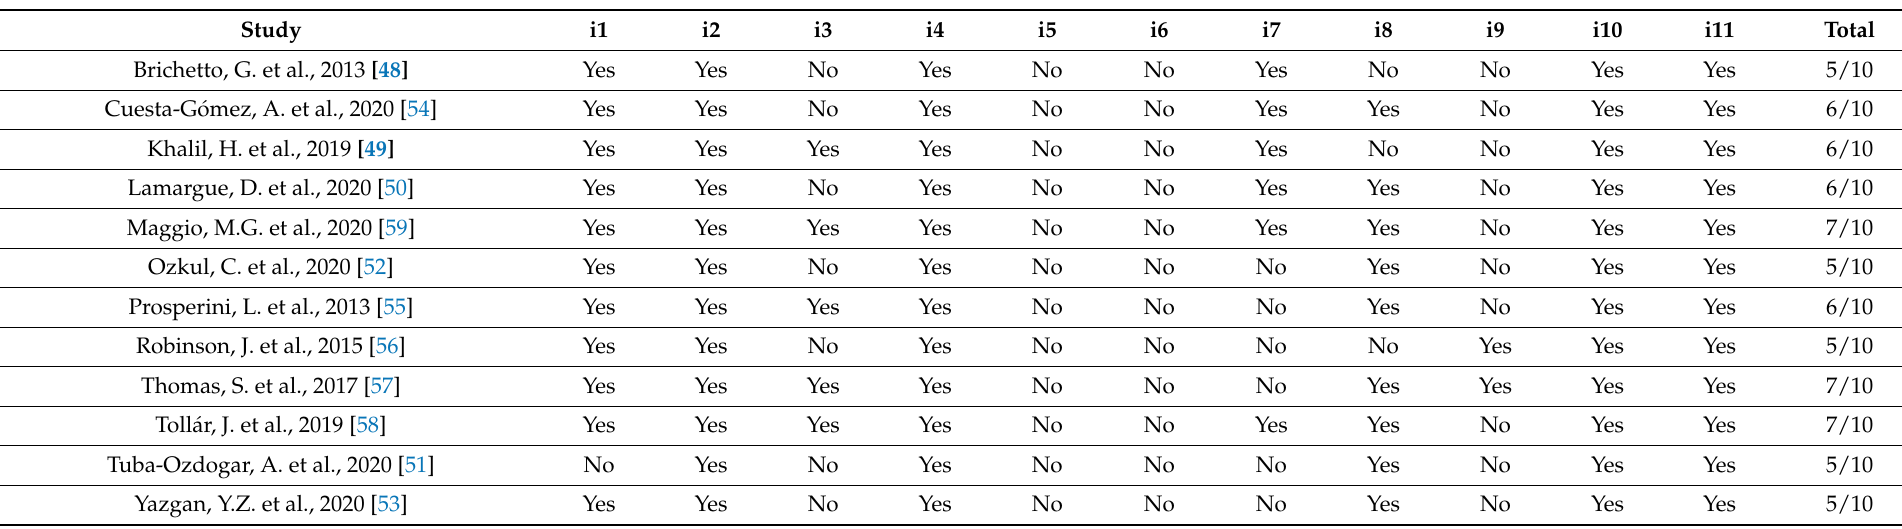
Table 3. Score of Included Studies from PEDro